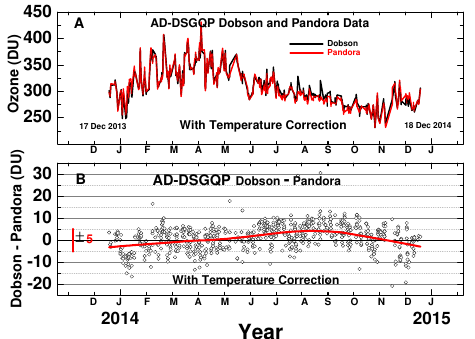
Figure 5. (a) OMI overpass TCO data for Boulder, Colorado, com- pared to Pandora TCO data averaged over a 16min interval centered on the OMI overpass time. (b) OMI TCO – Pandora TCO and a Lowess(0.2) fit (red curve).